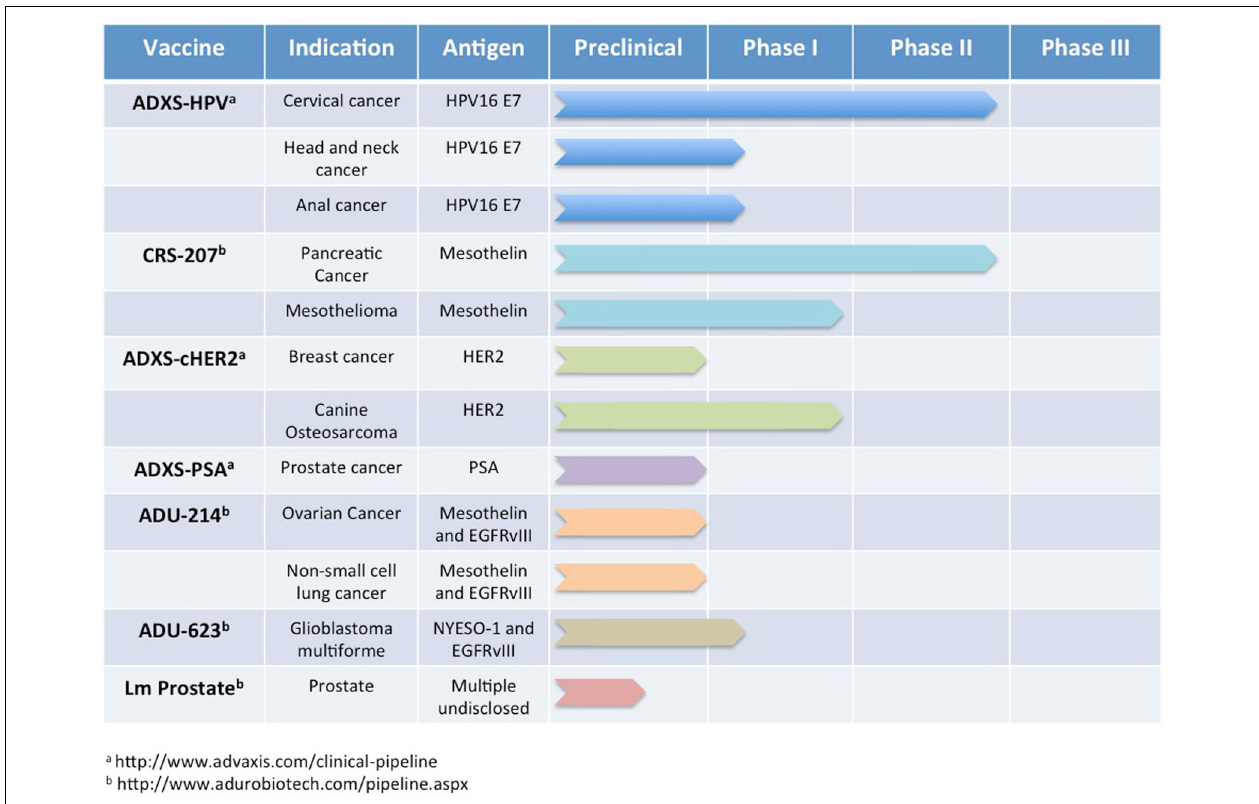
FIGURE 3 | Lm -based vaccine clinical trials pipeline. Numerous Lm -based vaccines have progressed through the discovery and preclinical phase of development and are now being administered to oncology patients for a